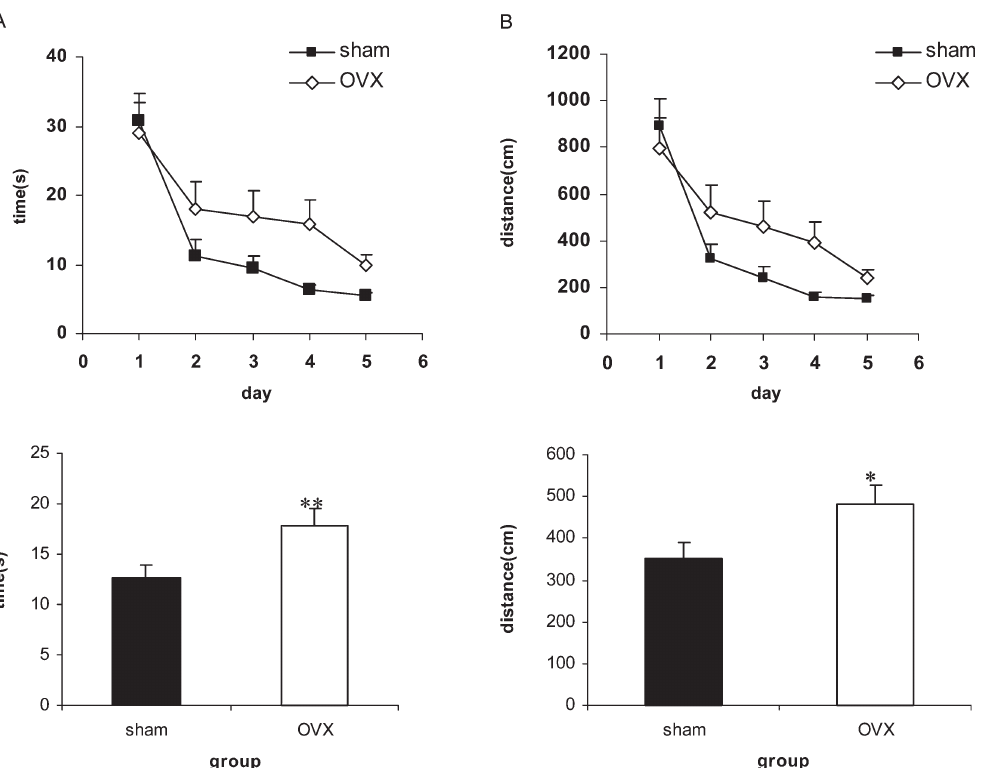
Figure 1 - Comparison of time latency (A) and traveled path length (B) between sham and OVX groups. Data are presented as mean ¡ SEM. (n=8)* P , 0.05, ** P , 0.01 compared to OVX group. The upper portion of the figure compares groups’ total time latency or traveled